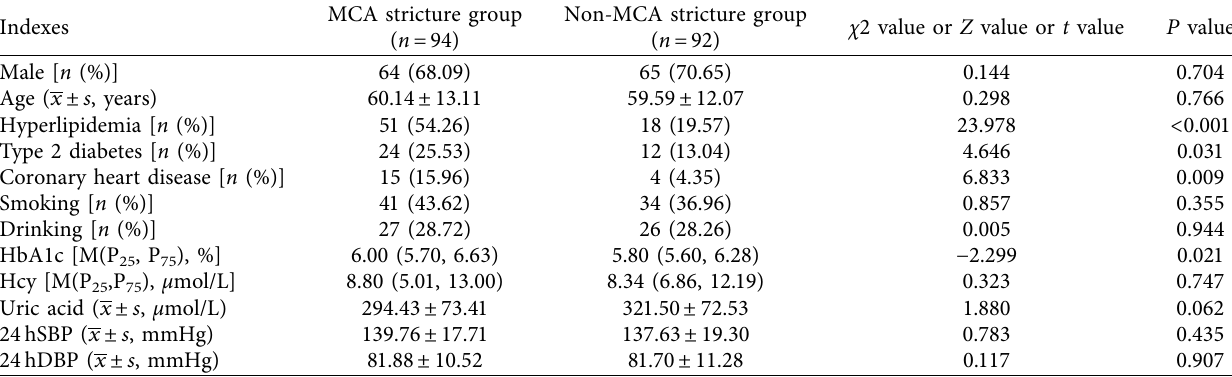
Table 1: Comparison of case data between the MCA stenosis group and the no MCA stenosis group.